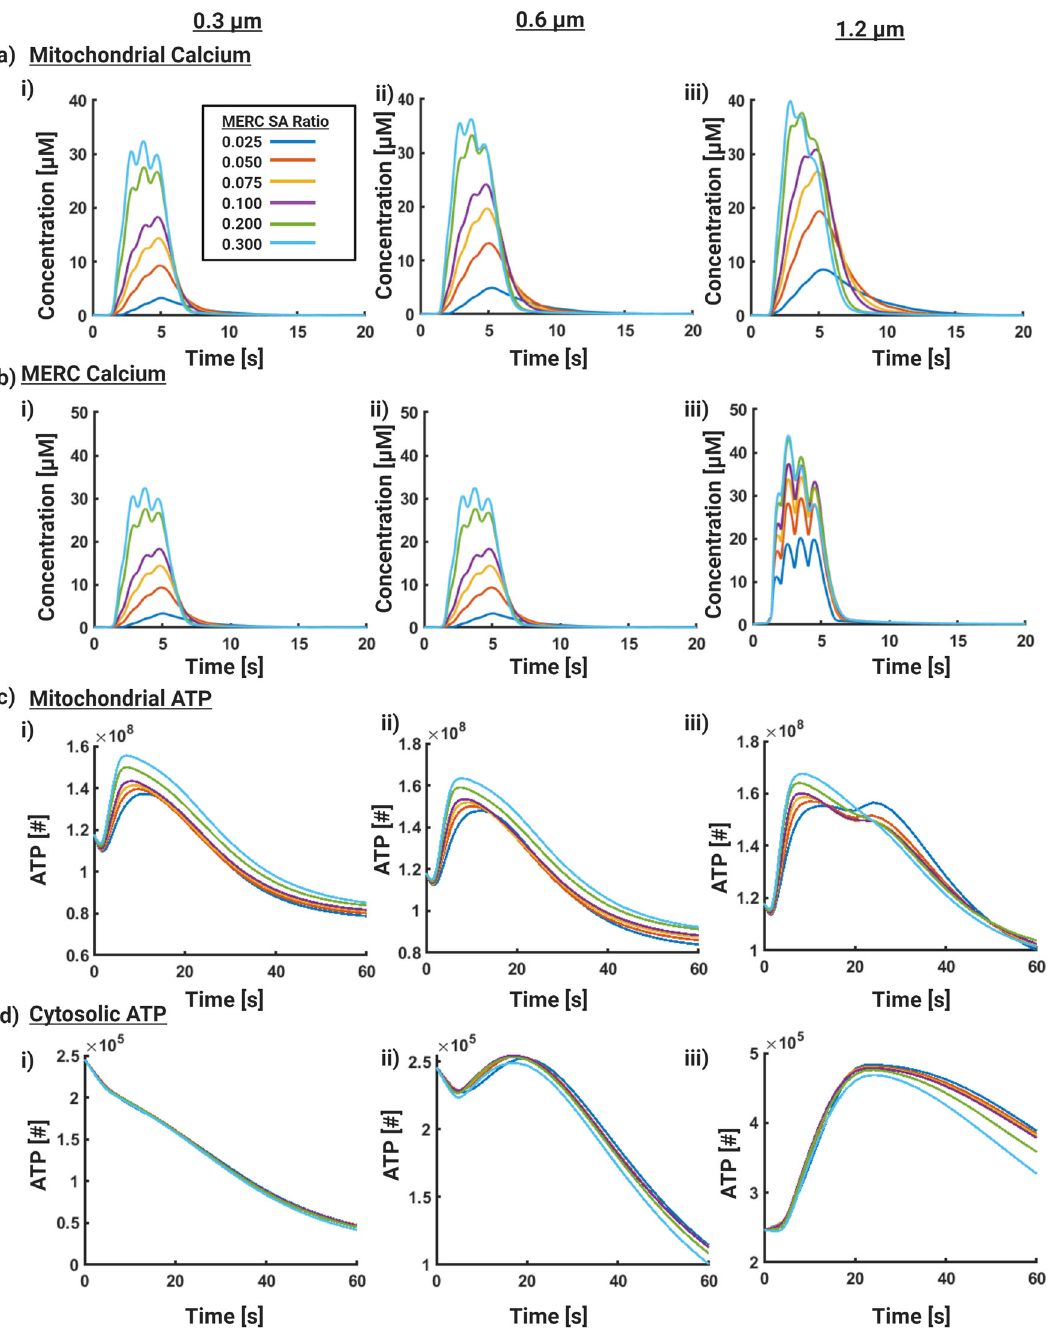
Fig. 5 Effect of MERC area fraction on ATP production. Here we vary the size of the mitochondria and the area fraction of MERC systematically. Three different mitochondrial sizes (0.3, 0.6, and 1.2 μ m) and six different MERC area fractions ranging from 0.025 to 0.3